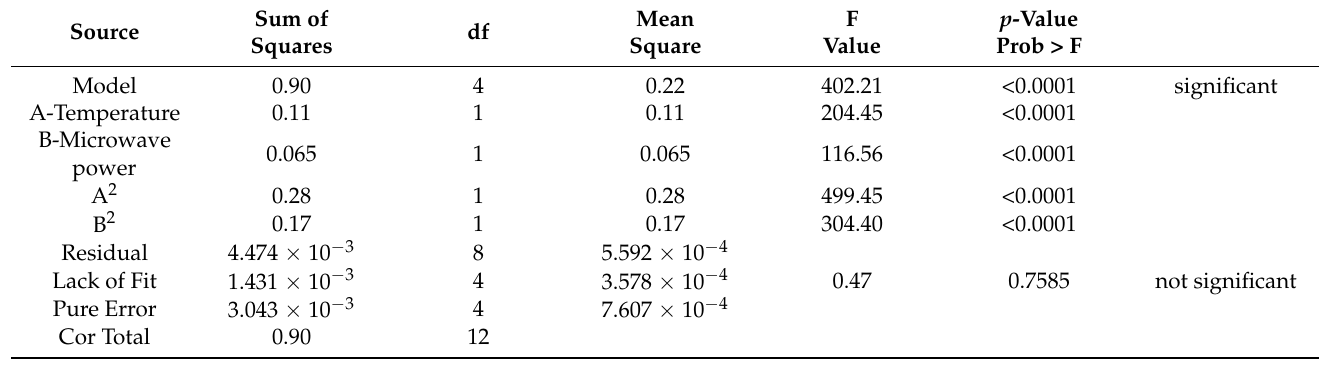
Table 8. Analysis of variance for shrinkage response using RSM.